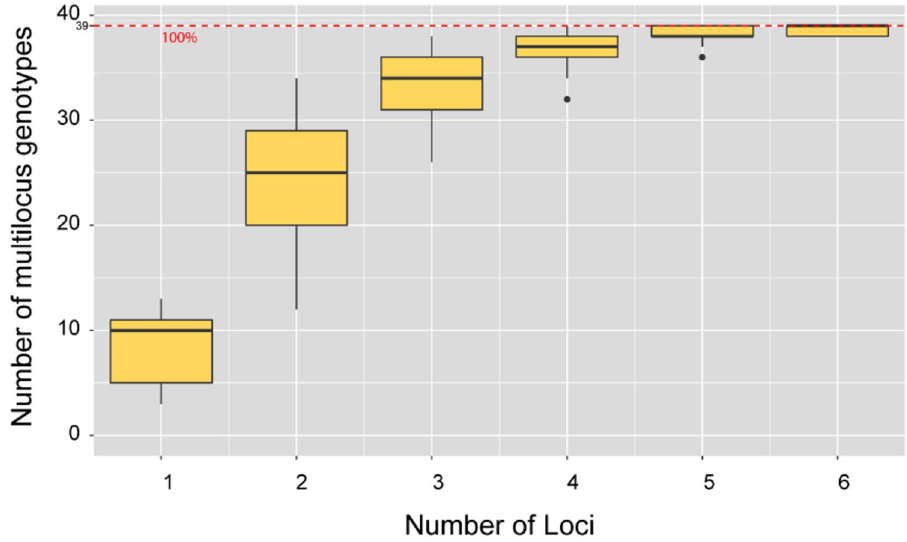
Figure 7. Number of multilocus genotypes based on number of loci from 39 individual of yellow-legged hornet. When the number of loci was 6 or more, the 39 individuals could be separated about 100%.